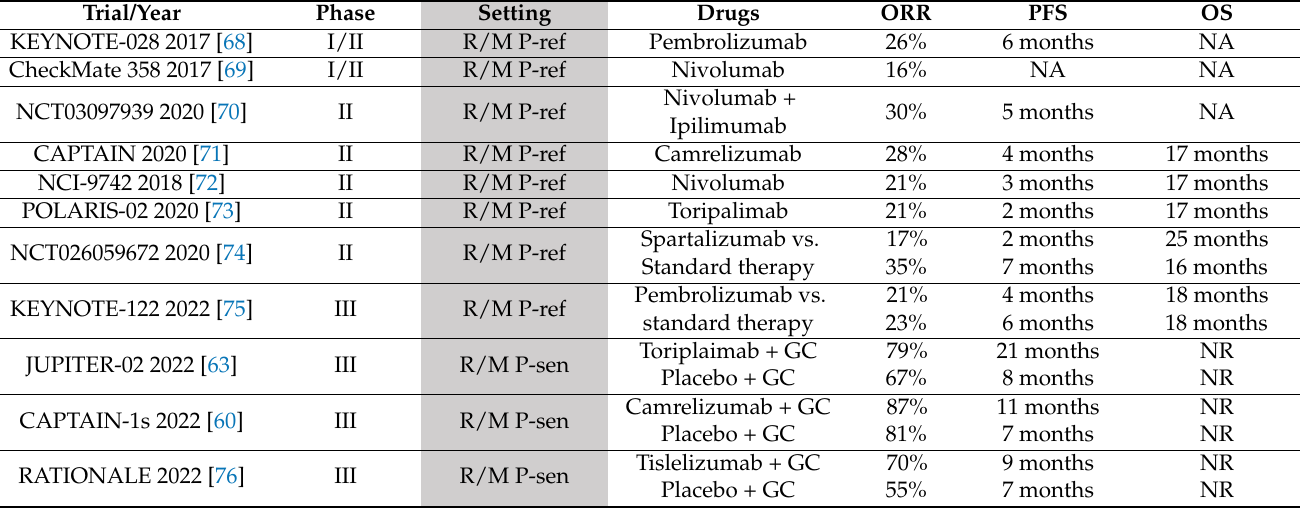
Table 1. Clinical trials with check-point inhibitors enrolling patients with recurrent/metastatic